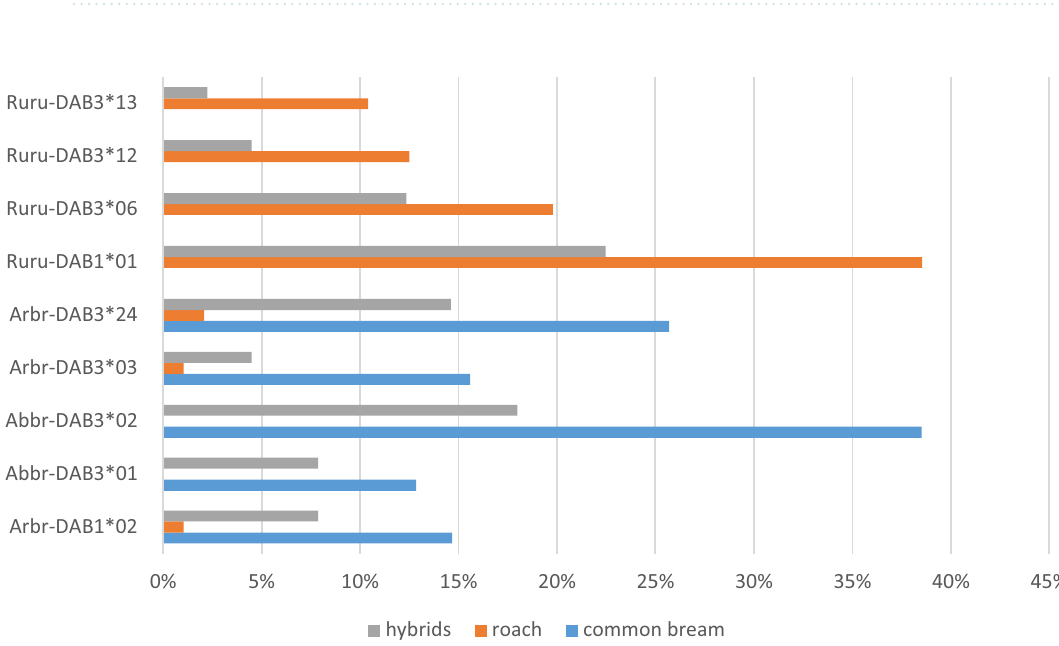
Figure 1. The frequencies of the most common DAB alleles in common bream, roach and their F1 hybrids. Note that only the frequencies of the most frequent alleles for common bream (5 alleles) and roach (4 alleles) are